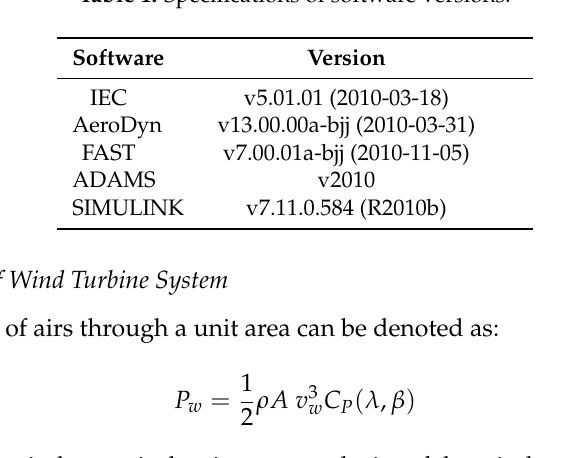
Table 1. Specifications of software versions.